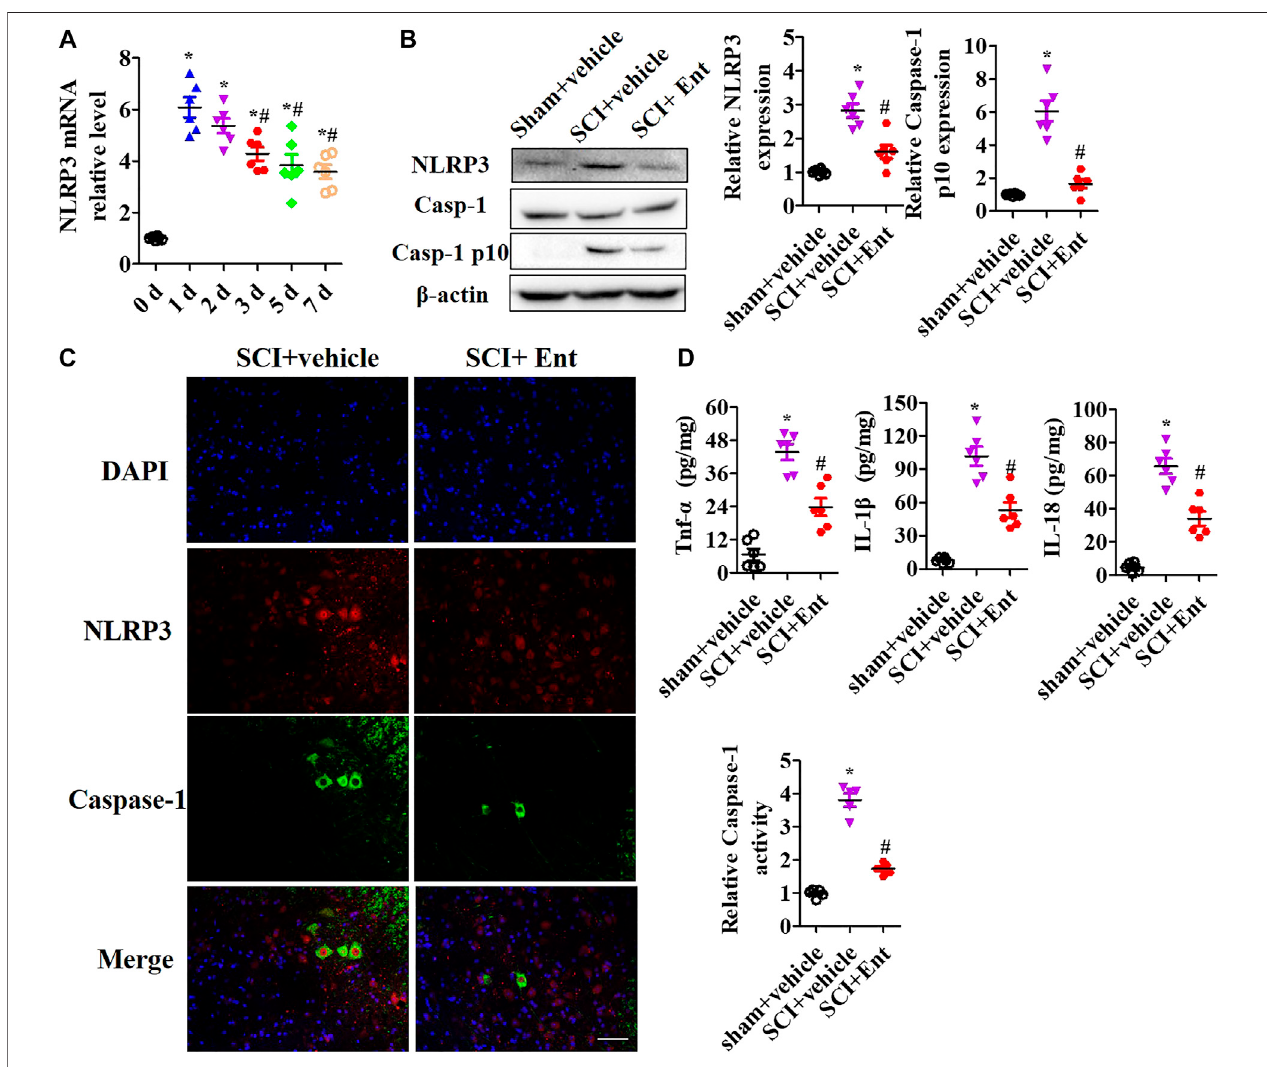
FIGURE4| EntinostatinhibitsNLRP3in fl ammasomeactivationinthespinalcord afterSCI.NLRP3 in fl ammasome activationwasmeasuredinthespinalcord after SCI. (A) qPCRanalysisofNLRP3mRNAduring7 dayspost-SCI. (B) WBanalysisofNLRP3,Caspase-1expressioninspinalcordafterSCIat7 days.Histogramanalysis oftheprotein relative expression, vs. β -actin. (C) NLRP3/caspase-1 double stainingwasperformed, andthenucleiwerestainedwithDAPI.Scalebar:50 μ m. (D) ELISA analysis of the levels of TNF- α , IL-1 β , and IL-18 in the spinal cord. (E) Caspase-1 activity was detected using Caspase-1 Activity Assay Kit after SCI. Data are expressed as the mean ± SEM, n (cid:1) 5. * p < 0.05, vs. the sham + vehicle group; # p < 0.05, vs. the SCI + vehicle group.